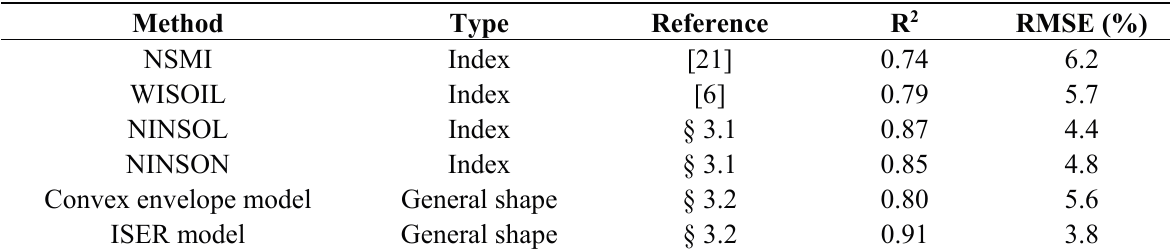
Table 5. Synthesis of methods and performance computed with validation data